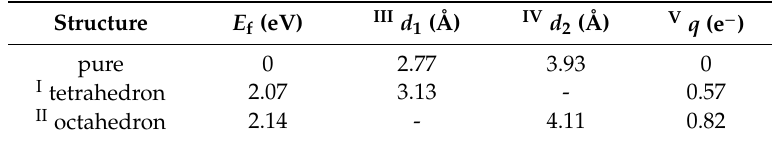
Table 1. The formation of energy and structural features after doping one C atom in tetrahedral or octahedral interstices in Pt lattice, in which, the formation energy was calculated using the formula,.